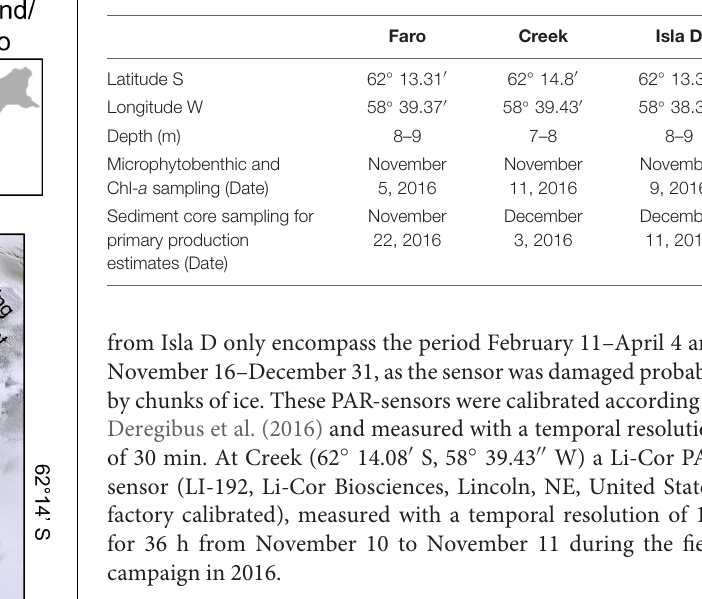
TABLE 1 | Locations, water depth at sampled locations, and date of